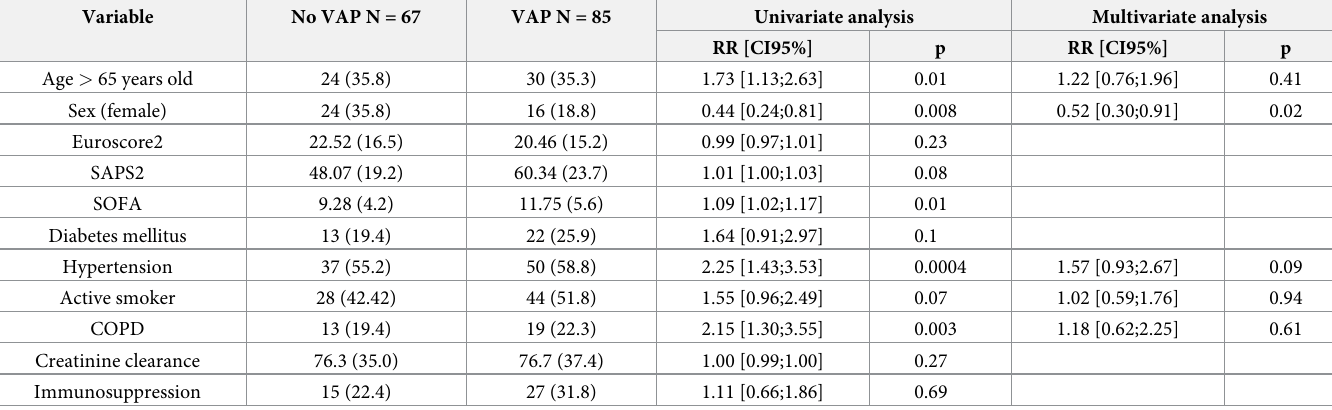
Table 3. Risk factors for VAP under ECMO.